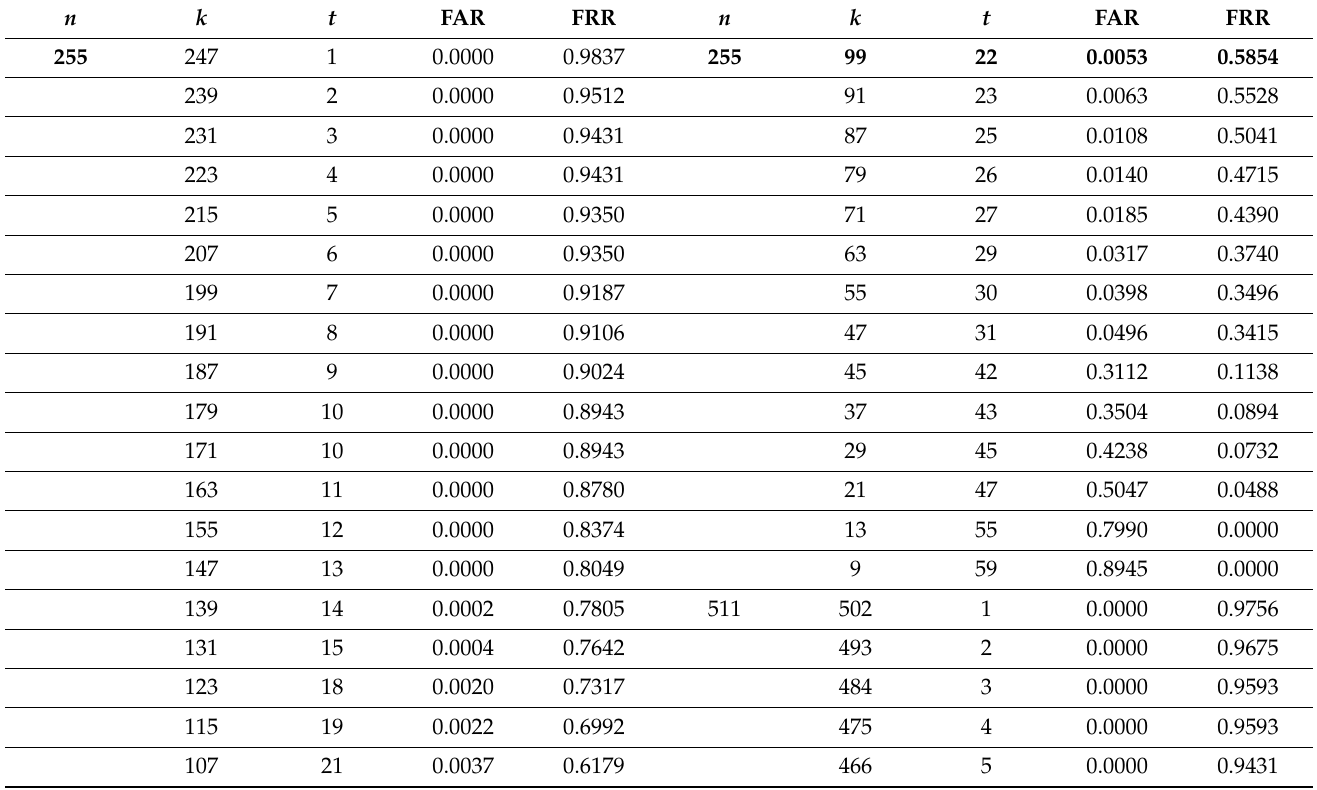
Table 4. The results of the second experiment (with n = 255 and n = 511) for the Touchalytics dataset.